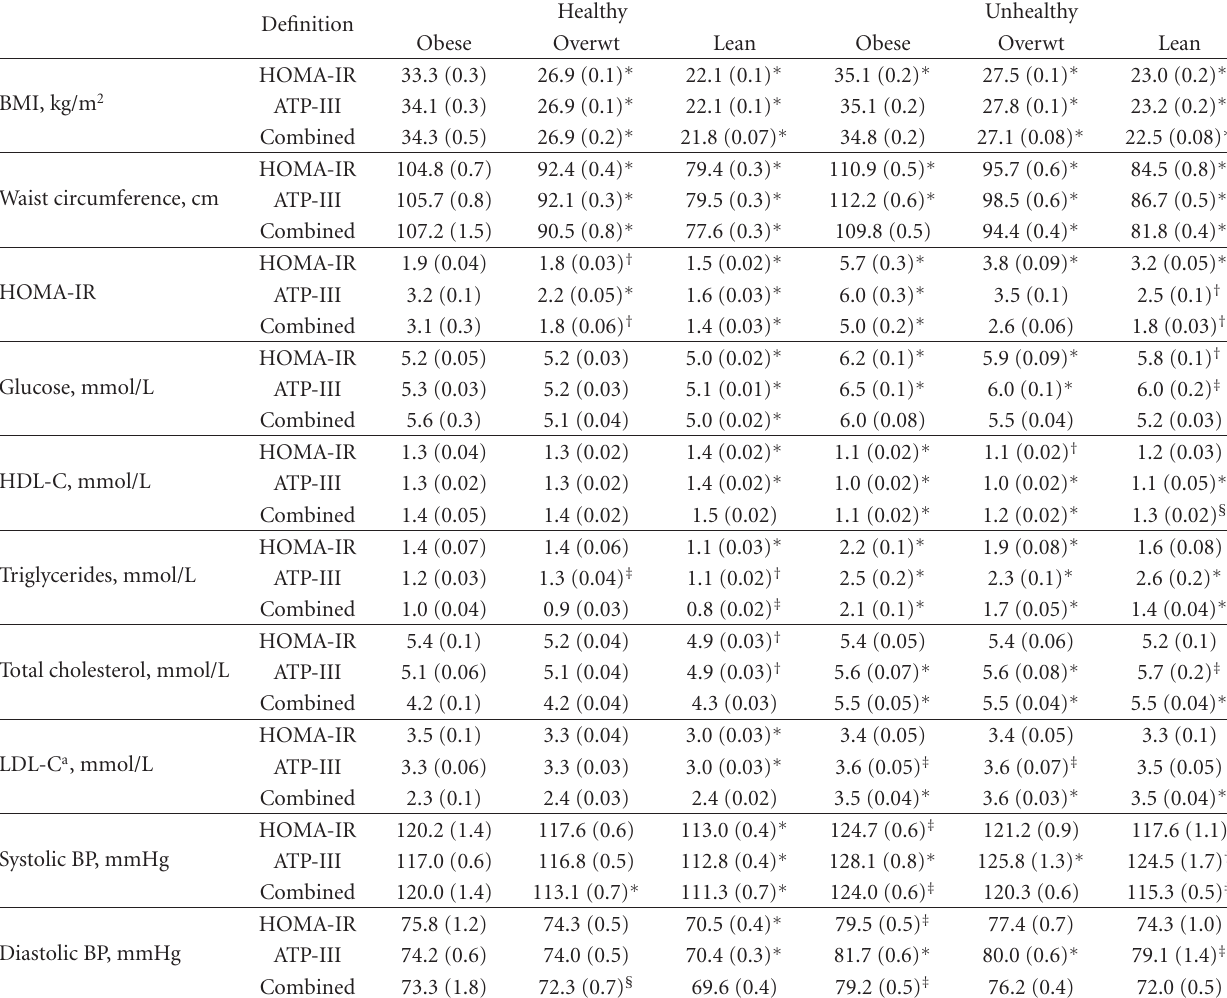
Table 4: Anthropometric and clinical characteristics by metabolic health and body mass index category shown as weighted mean (SEM).